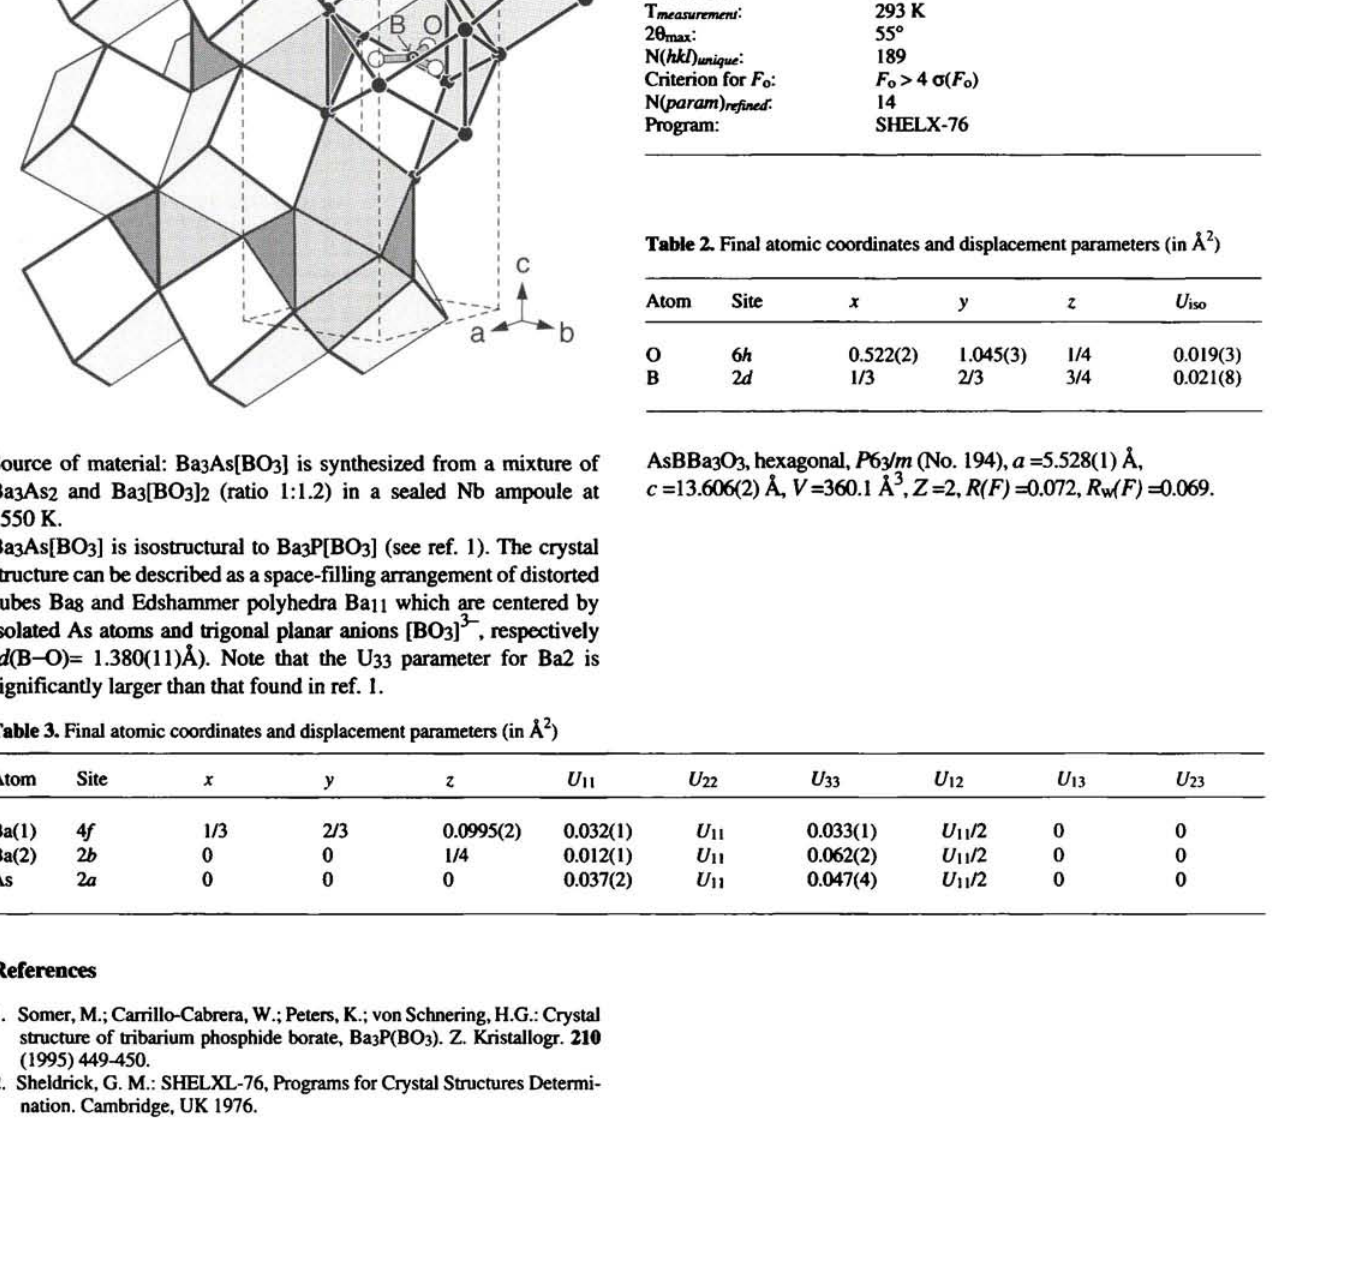
Table 1. Parameters used for the X-ray data collection Crystal: